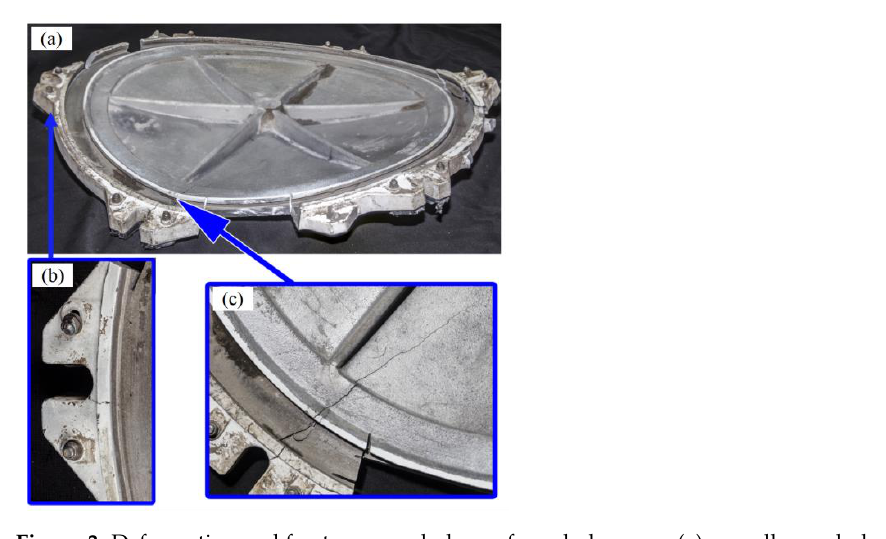
Figure 3. Deformation and fracture morphology of manhole cover: ( a ) overall morphology, ( b ) crack morphology at four o’clock, ( c ) crack morphology at six o’clock.